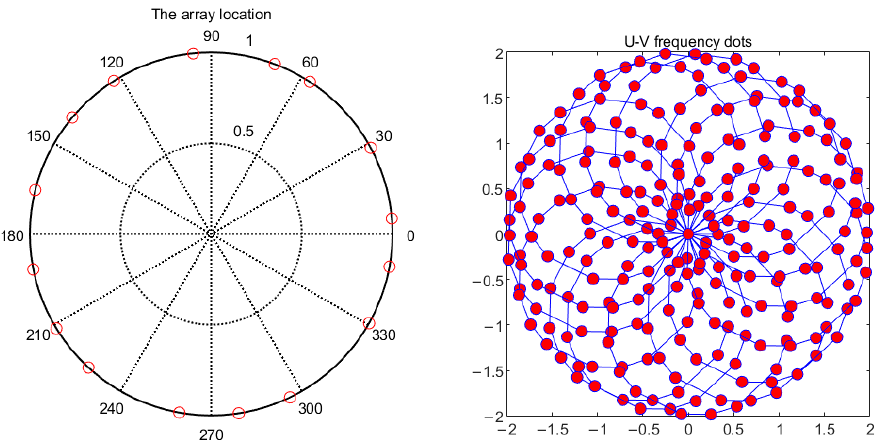
Figure 2. The arrangement of the antenna units and the U-V distribution diagram.